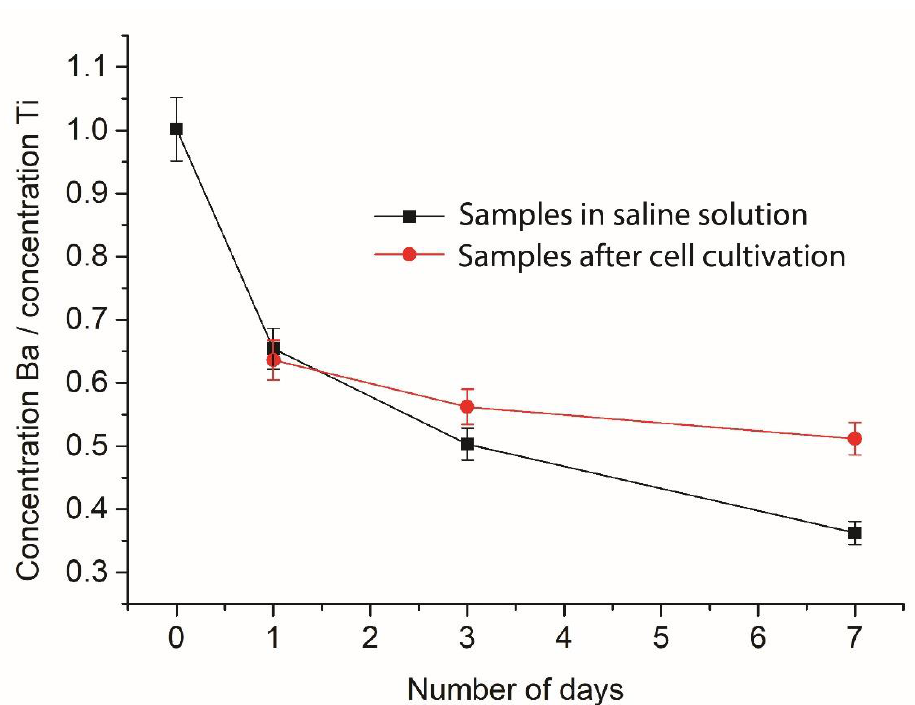
Figure 7. Decrease of the Ba/Ti concentration ratio in BaTiO 3 -coated Ti39Nb samples after 1, 3 and 7 days of leaching in the physiological saline solution (black) or after 1, 3, or 7 days of cell cultivation (red). Error bars mean 5% of values presented in the graph, which is usually supposed inaccuracy in XPS results. The analysis was performed on a circle of 5 mm in diameter on one sample per each experimental group and time interval.